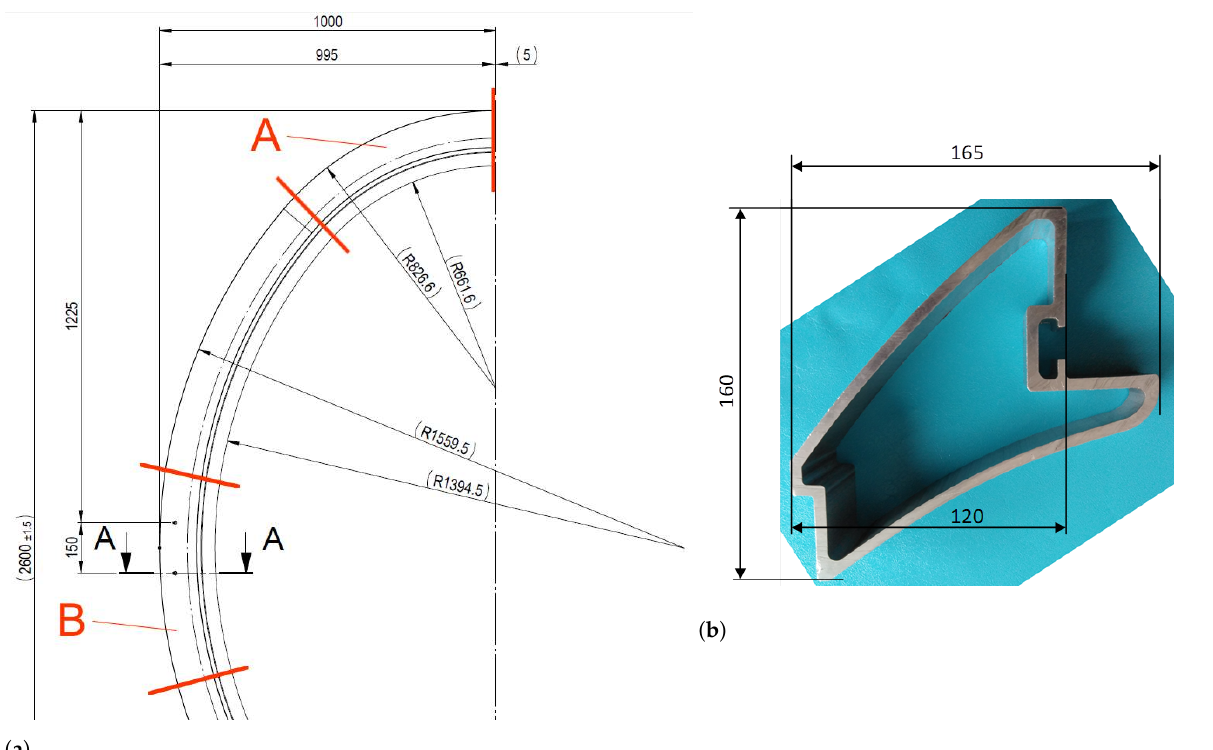
Figure 4. Dimensions of the profile forming ( a ) the ring “A” and “B”, and ( b ) section through the profile used to create the gondola